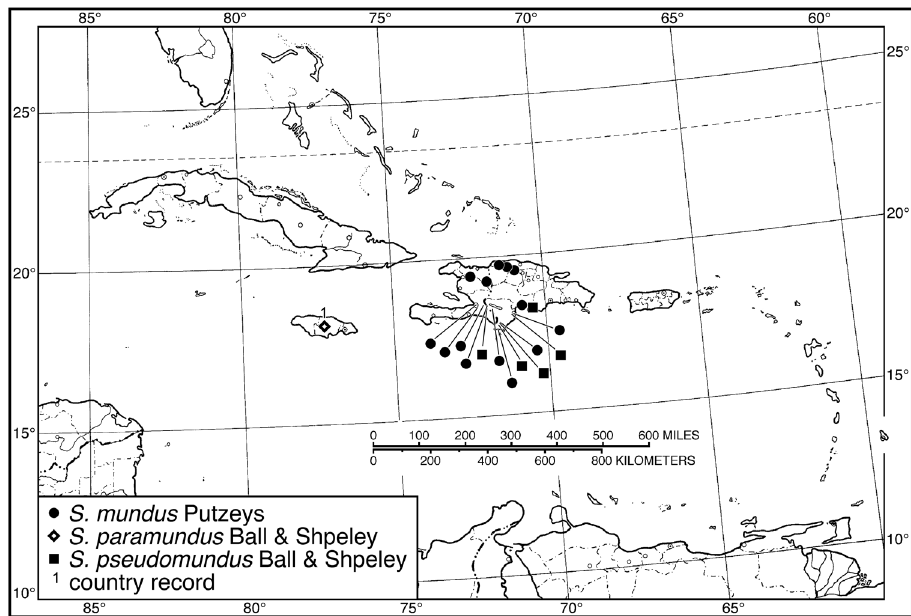
Figure 34. Map of West Indies showing known localities for species of Selenophorus mundus species